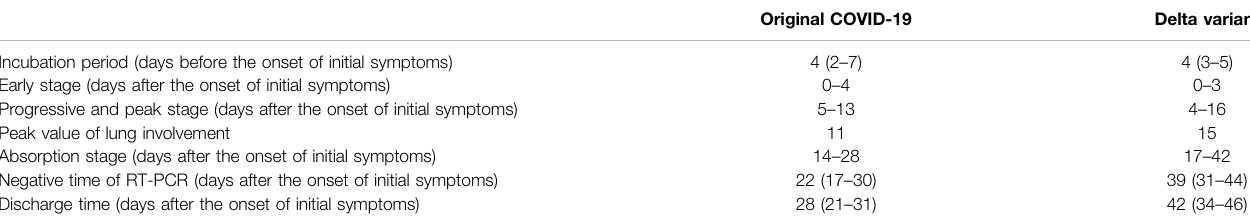
TABLE 2 | Different time courses of Original COVID-19 and Delta